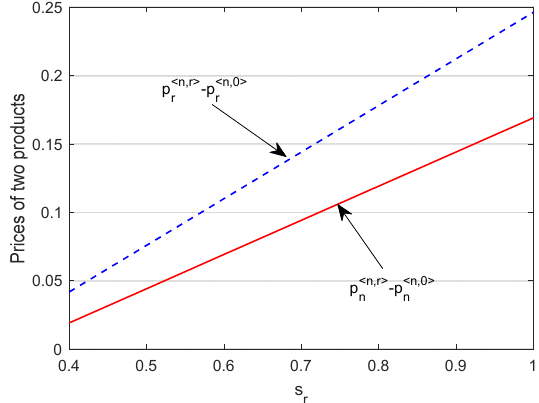
Figure 3. Price comparison between < n , 0 > and < n , r >.